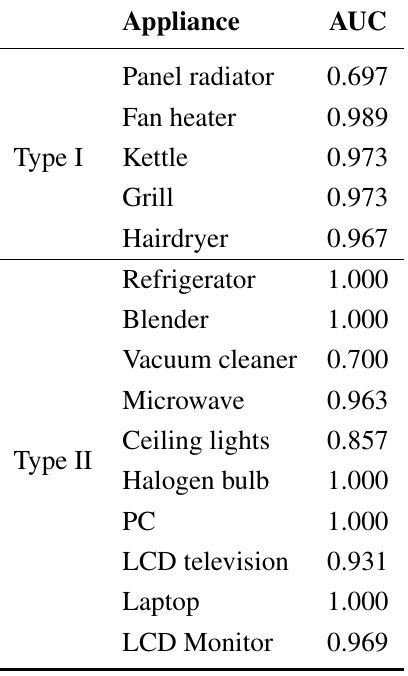
Table 8. Area under the curve (AUC) values for classifying the correct type to an appliance based on features from the ON transient